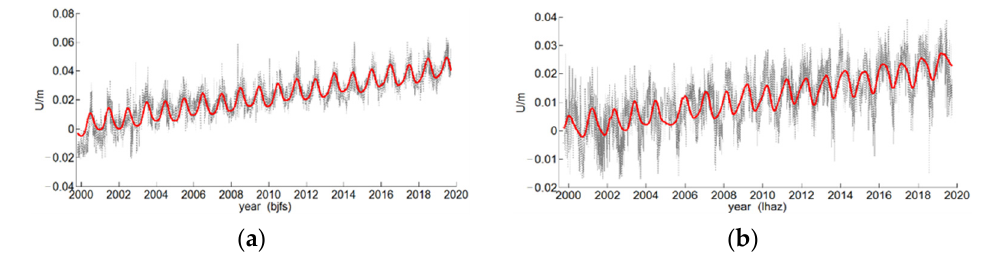
Figure 2. Fitting curve of bjfs ( a ) and lhaz ( b ) CORS height model. Table 2. Fitting parameters of bjfs and lhaz CORS height model.